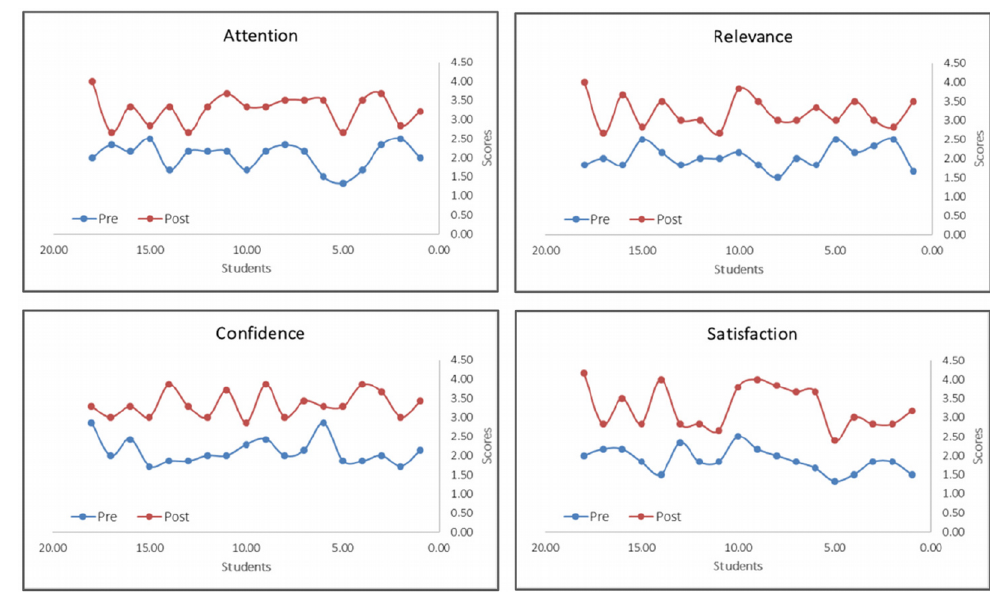
Figure 7. Students’ score in SSM Pretest and Posttest